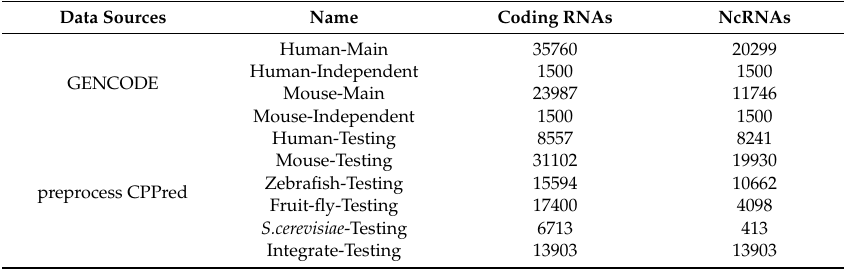
Table 1. Summary of